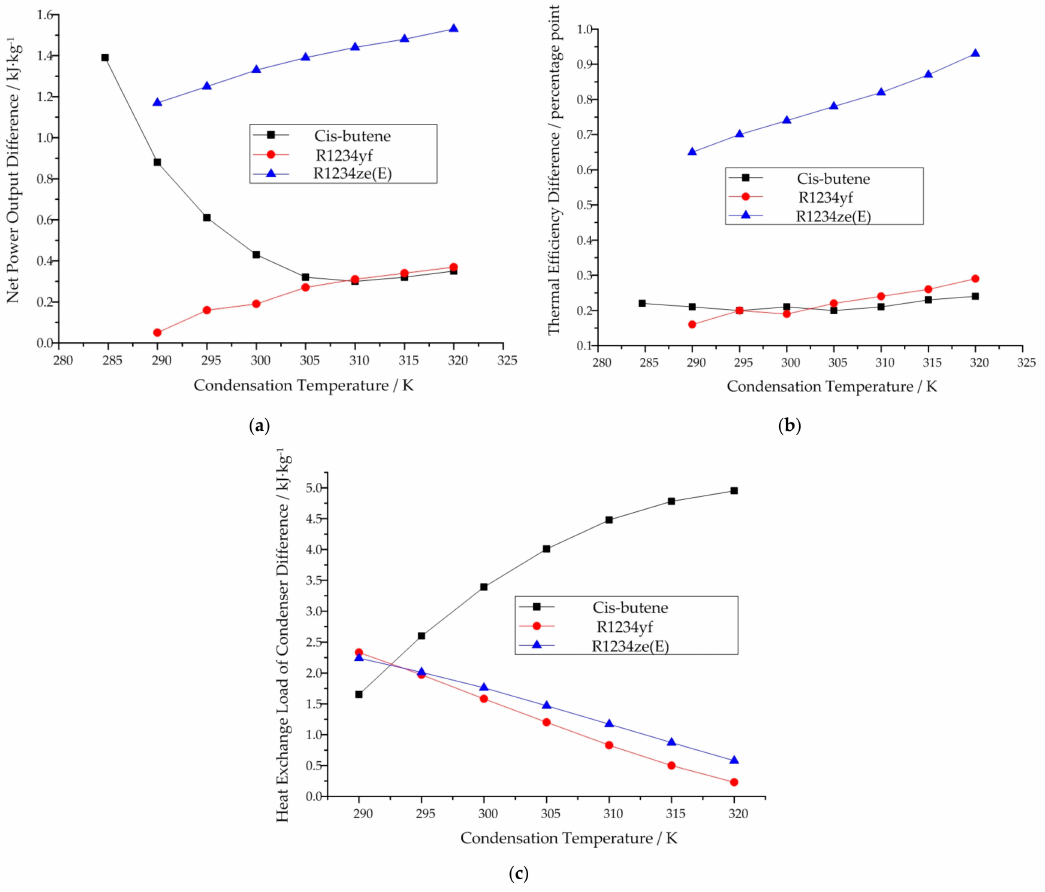
Figure 8. Variation in the di ff erence in thermodynamic performance with increasing condensation temperature in the subcritical cycle model when the condensation temperature is known: ( a ) net power output, ( b ) thermal e ffi ciency, ( c ) heat exchange load of the